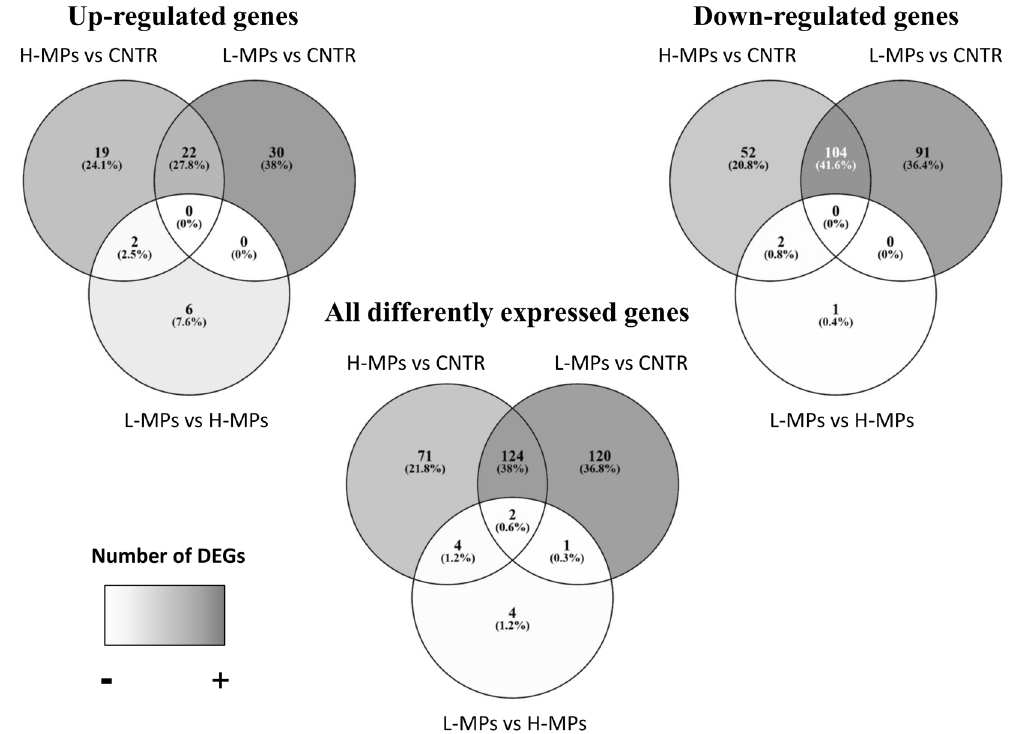
CNTR (Control), L-MPs (100 µ g/L) vs CNTR (Control) and L-MPs (100 µ g/L) vs H-MPs (1000 µ